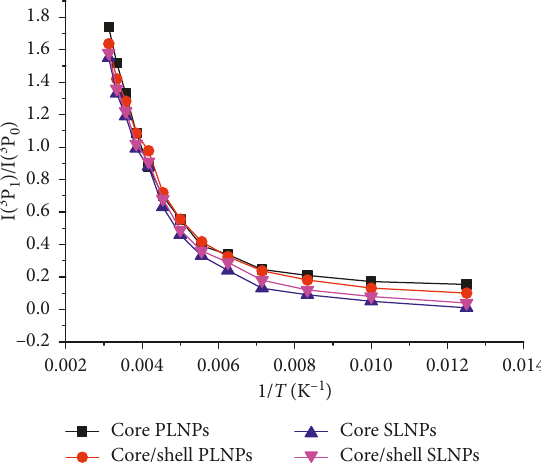
Figure 8: Luminescence intensity ratio of 3 P